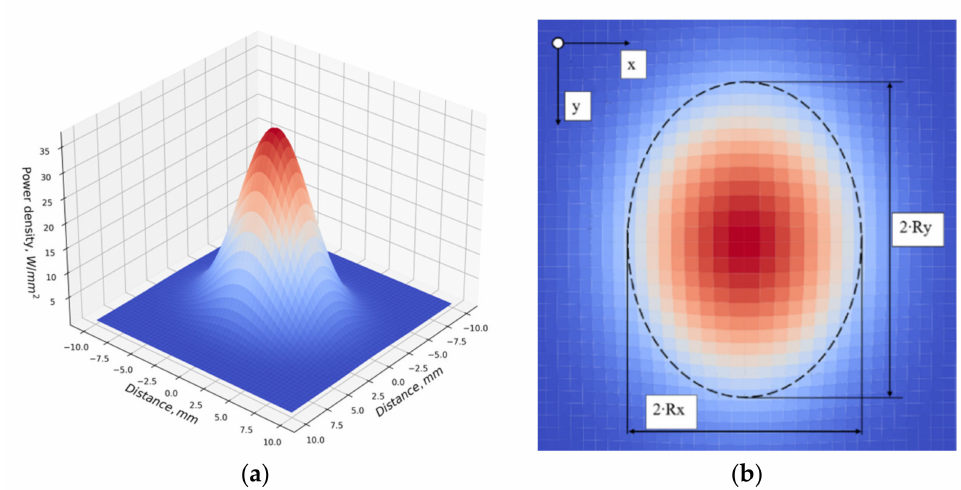
Figure 4. Power density distribution of the heat source: ( a ) 3D power density distributions of the heat source; ( b ) source distribution zone parameters.